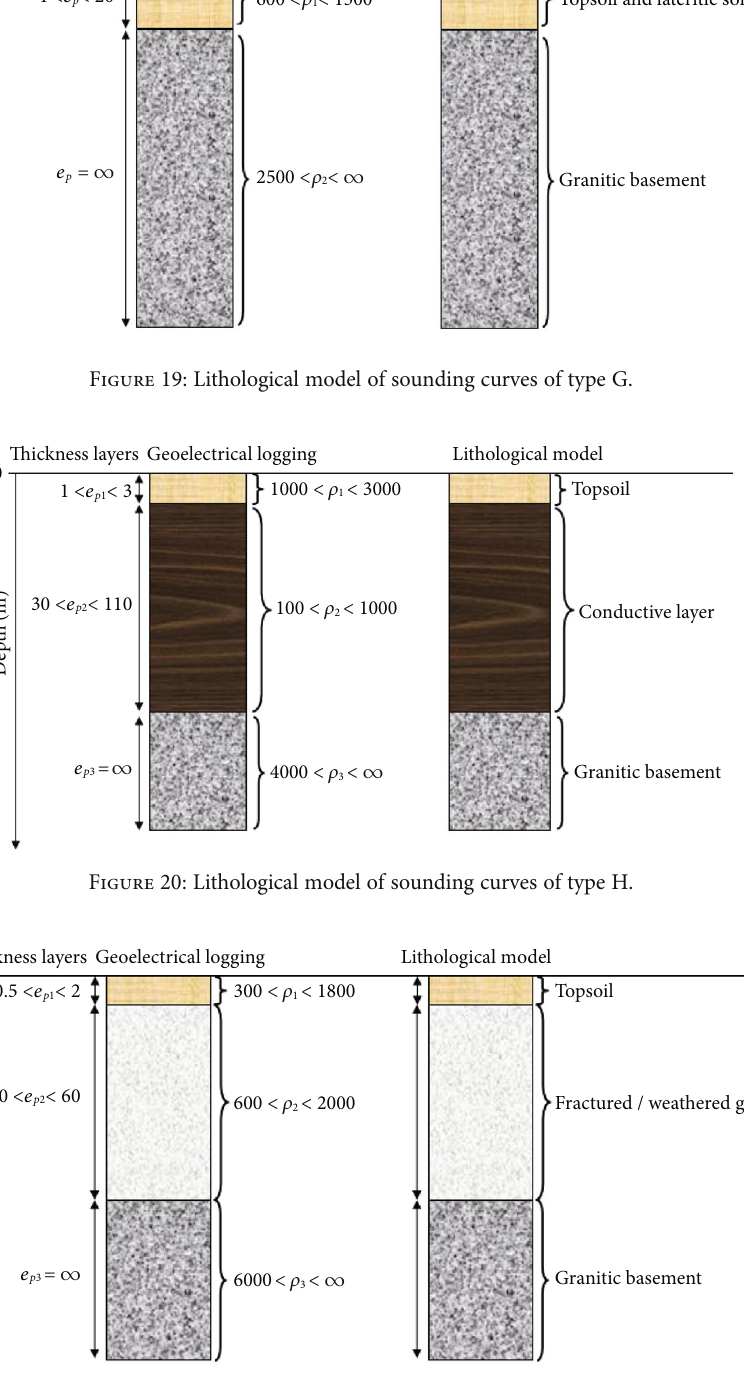
Figure 21: Lithological models of the sounding curves of type